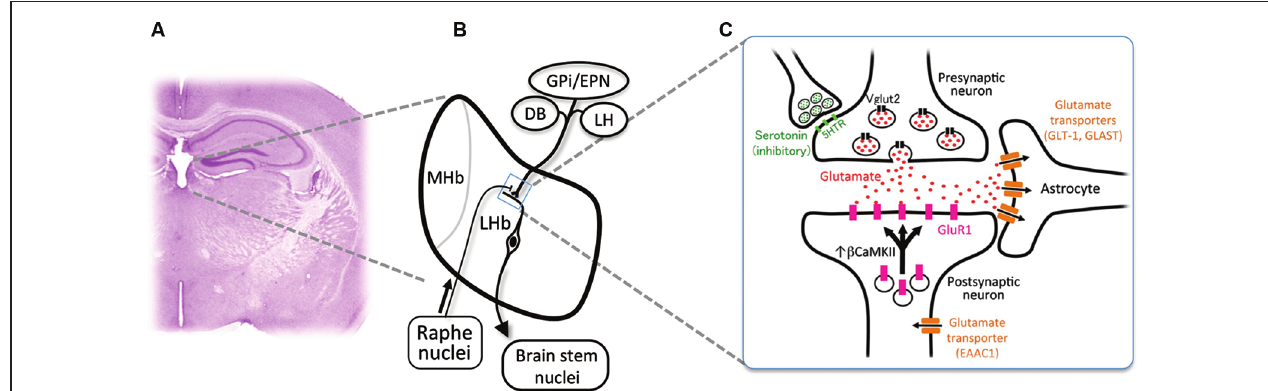
rectangles, Vglut2). Serotonin (green dots) acts on the presynaptic axonal terminal through serotonin receptors (light green rectangles, 5-hydroxytryptamine (serotonin) receptor (5HTR)) to inhibit the excitatory transmission. Released glutamate binds and activates the a-amino-3-hydroxy-5-methyl-4-isoxazole propionic acid (AMPA)-type glutamate receptor containing GluR1 subunit (pink rectangles) whose transporters (brown rectangles) expressed in astrocytes (GLT-1 and GLAST) and neurons (EAAC1) clear the glutamate released to synaptic